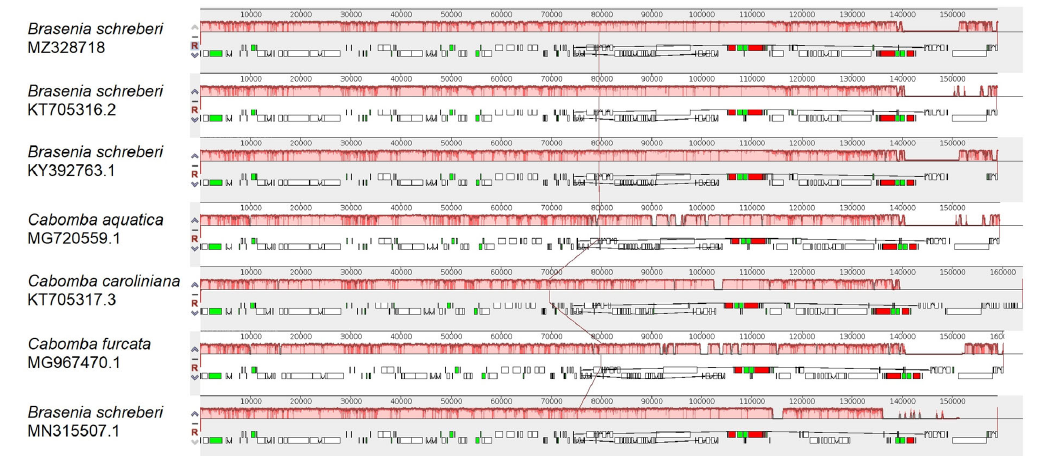
Figure 8. Chloroplast sequence homology analysis. Note: The long squares in the figure represent the similarity between genomes, and the connection between the long squares represents a collinear relationship. Short squares represent gene positions for each genome. Among them, white represents CDS, green represents tRNA, and red represents rRNA.